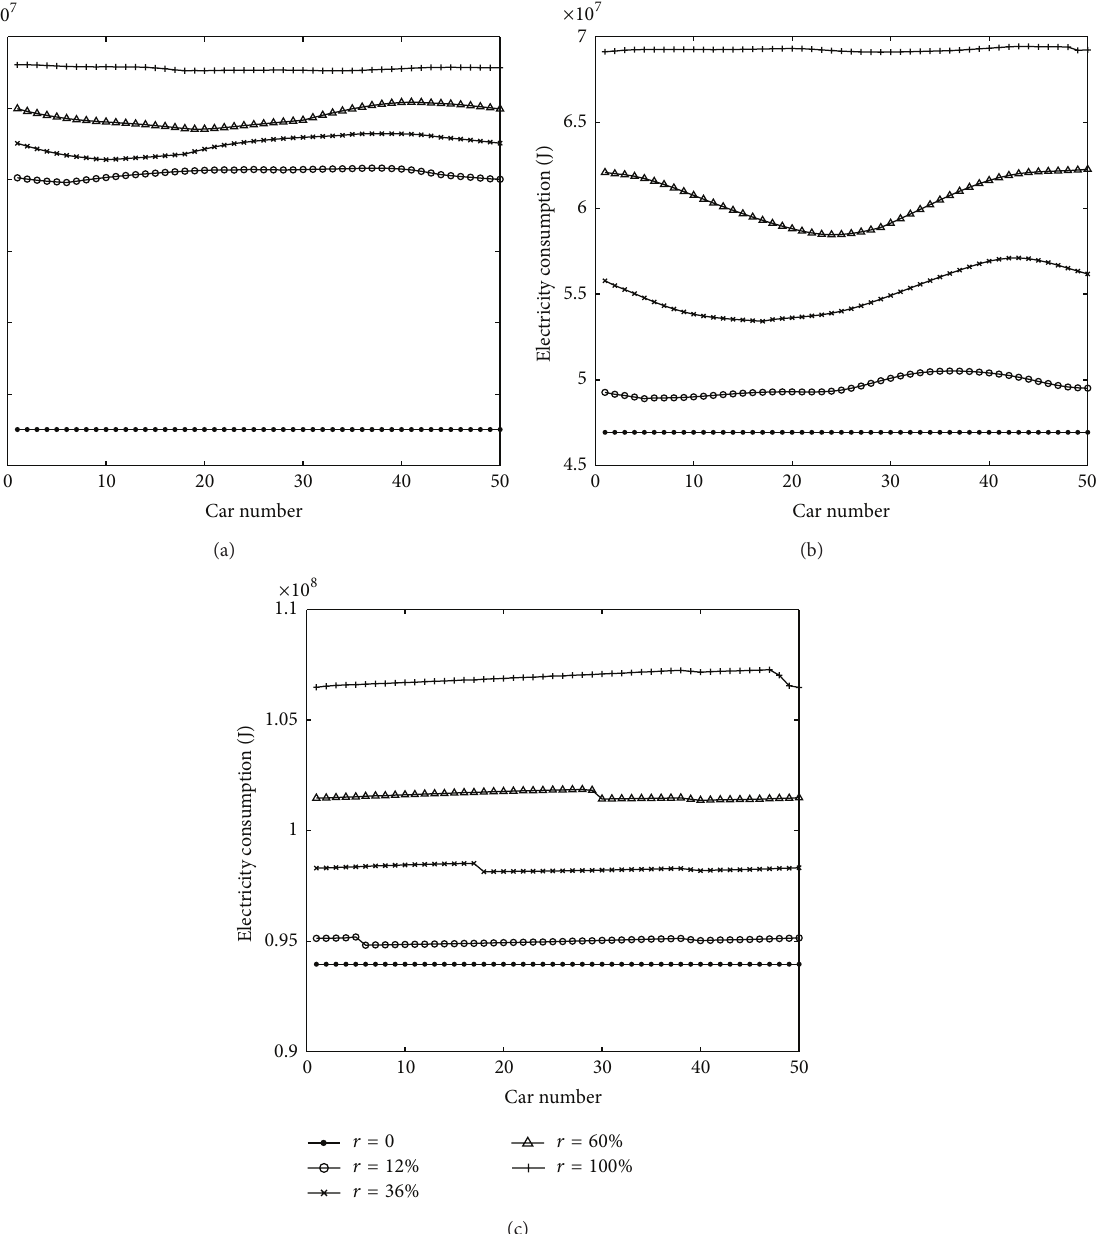
Figure 3: The total electricity consumed by each vehicle under 𝑇 0 = 120 s, where (a) Δ𝑥 0 = 20 m, (b) Δ𝑥 0 = 40 m, and (c) Δ𝑥 0 = 80 m.